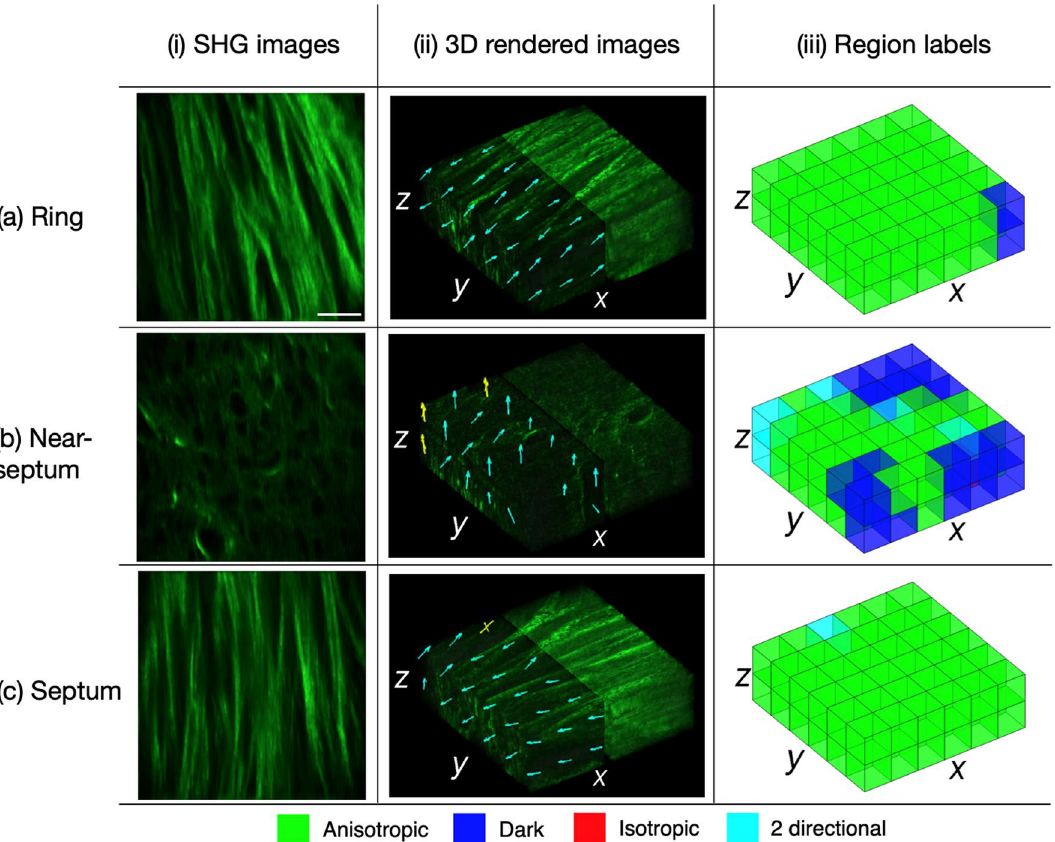
Figure 2. Representative 2D SHG images and results from the 3D FT-SHG analysis of three distinct regions on rat cervix tissue. Each row represents the ( a ) ring, ( b ) near-septum and ( c ) septum. The orientation of the fibers in the anisotropic volume elements are overlaid on the 3D rendered images and shown by arrows [column (ii)]. The cyan and yellow arrows represent volume elements with a single or two preferred fiber orientations, respectively. Each volumetric image (80 × 80 × 13 µm) consists of 72 volume elements (13 × 13 × 13 µm). Scale bar is 15